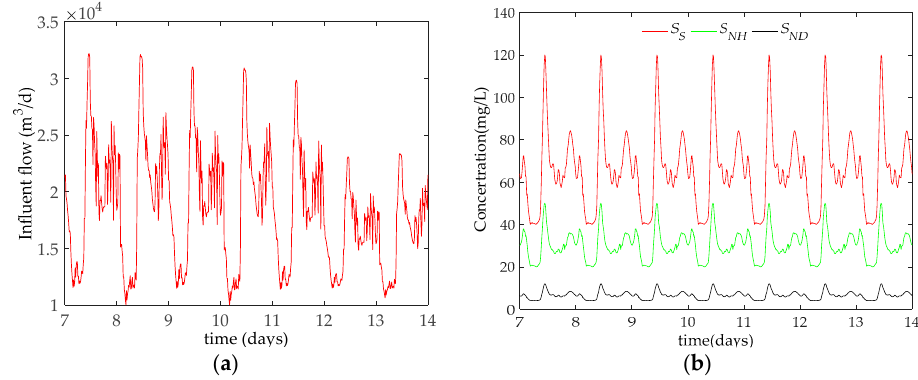
Figure 5. Dynamic data for experimental use: ( a ) Influent flow rate (days 7 to 14); ( b ) Concentration of some of the chemical species in the influent (days 7 to 14) ( S S —readily biodegradable substrate; S NH —ammonium and ammonia nitrogen; S ND —soluble biodegradable organic